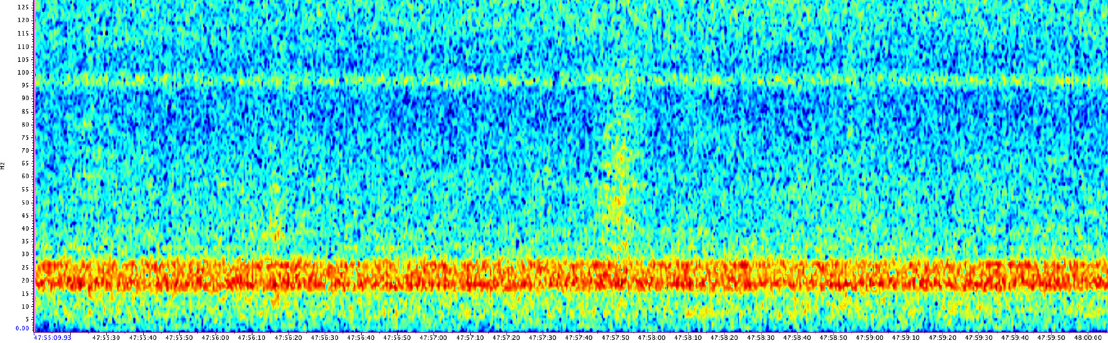
Figure A6. F20P log examples from file 20140604_150000 for the location Maud Rise.